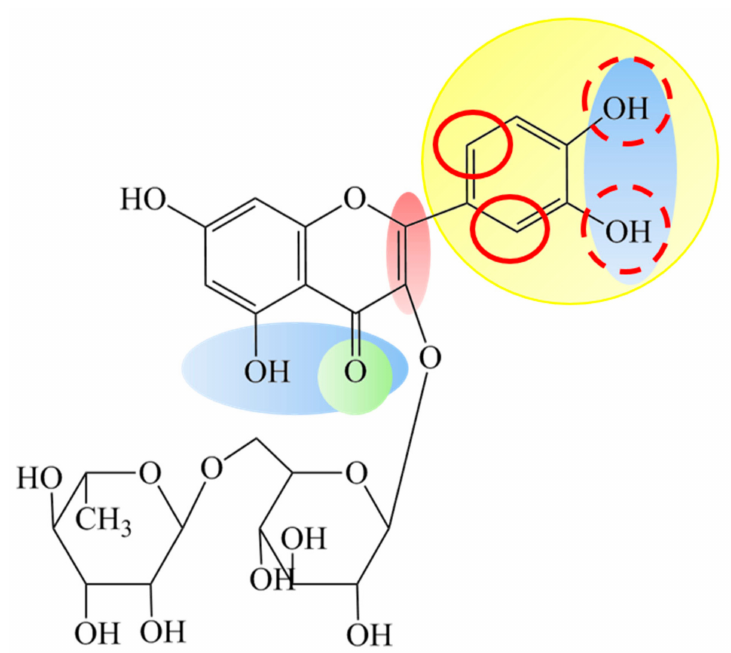
Figure 5. Structure of RU showing the features important in classical antioxidant